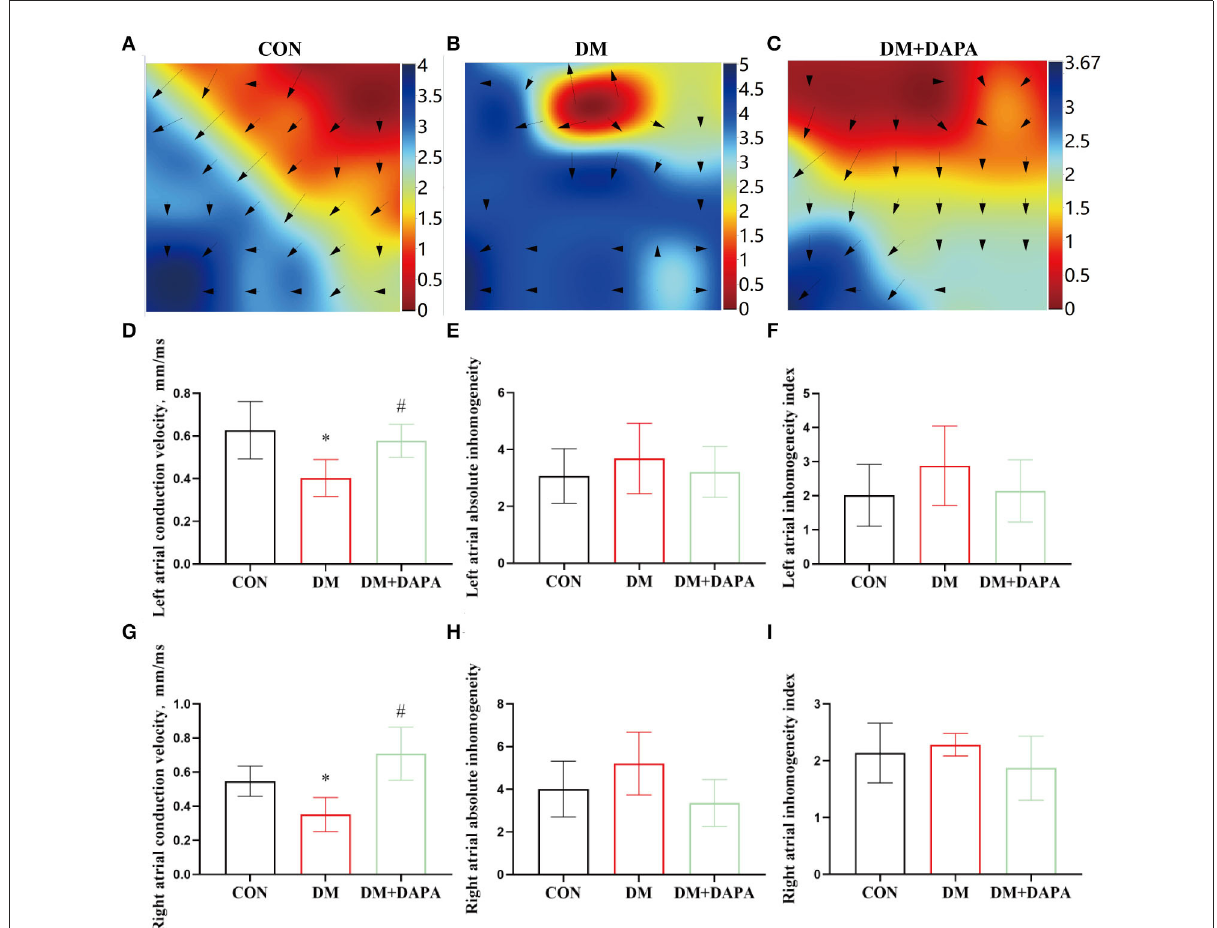
FIGURE3 Effects of DAPA on epicardial electrical conduction characteristics in STZ-induced diabetic rats. (A–C) Typical images of electrical mapping; The arrow represents the direction of the excitement; (D) statistical analysis of conduction velocity in left atrium ( n = 8); (E) statistical analysis of absolute inhomogeneity in left atrium ( n = 8); (F) statistical analysis of inhomogeneity index in left atrium ( n = 8); (G) statistical analysis of conduction velocity in right atrium ( n = 8); (H) statistical analysis of absolute inhomogeneity in right atrium ( n = 8); (I) statistical analysis